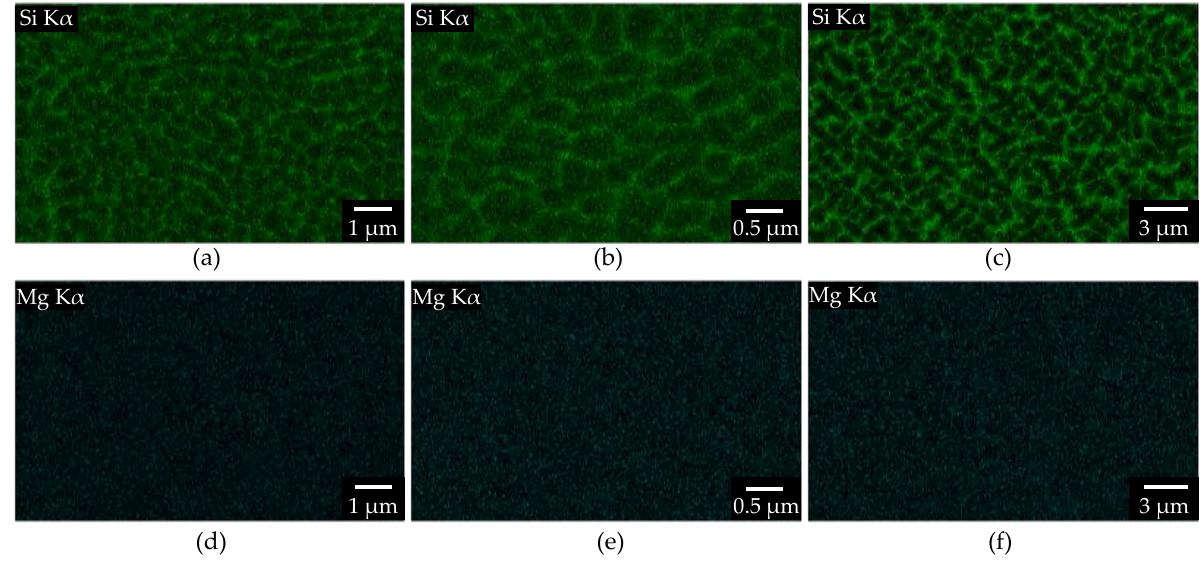
Figure 8. EDS image on various magnification with HV = 10 keV, I = 6.7 nA ( a , d ) PS 1, ( b , e ) PS 2, ( c , f ) PS 3 after 9 h in-situ aging.